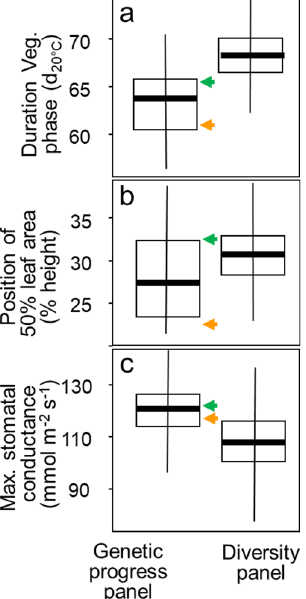
Fig. 6 The genetic progress (green and orange arrows) accounted for the largest part of the genetic variabilities of vegetative phase duration and of architecture, and for a small part of the genetic variability of stomatal conductance. Left boxes, genetic progress panel (presented here); right boxes, diversity panel with similar background. Green and orange arrows, median of the phenotypic value of the 22 most recent and 22 most ancient hybrids, respectively. Phenotypic values taken into account are the BLUES for each hybrid. a Duration of the vegetative phase; b Distance of the canopy layer with 50% of total leaf area from top, in % of canopy height (rh PAD ); c maximum stomatal conductance. n = 56, 60, and 60 hybrids in panels a – c , respectively. Bold lines in boxes, median; boxes, 25 and 75 percentiles; vertical lines, 25 and 75 percentiles multiplied by 1.5 of the interquartile range (25 – 75). Source data in Supplementary data